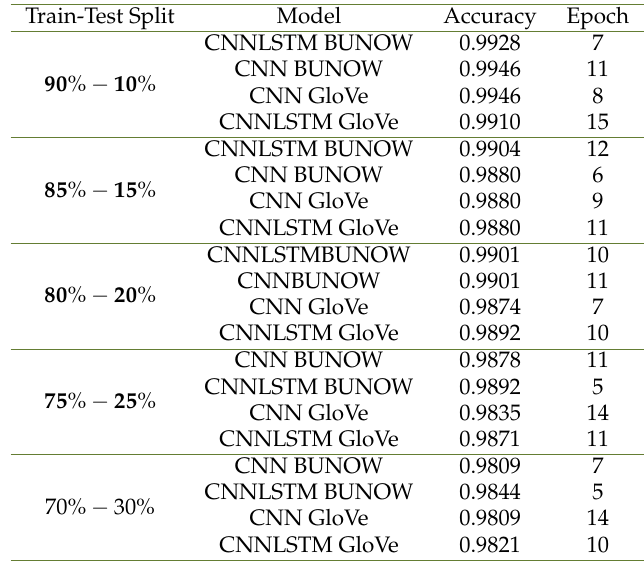
Table 3. Best Accuracies achieved by four models.